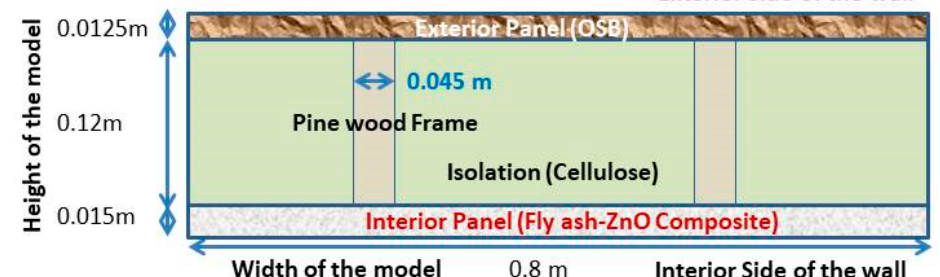
Figure 2. Two-dimensional hygrothermal model using COMSOL.